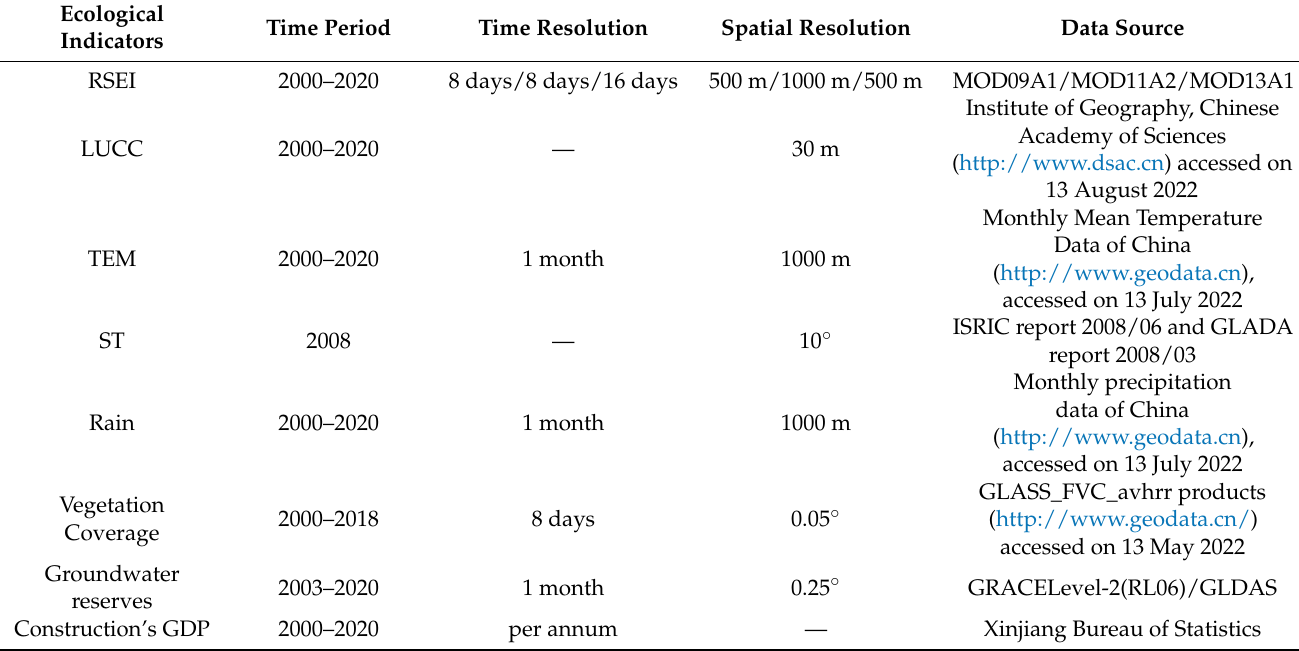
Table 1. Data and sources used by the